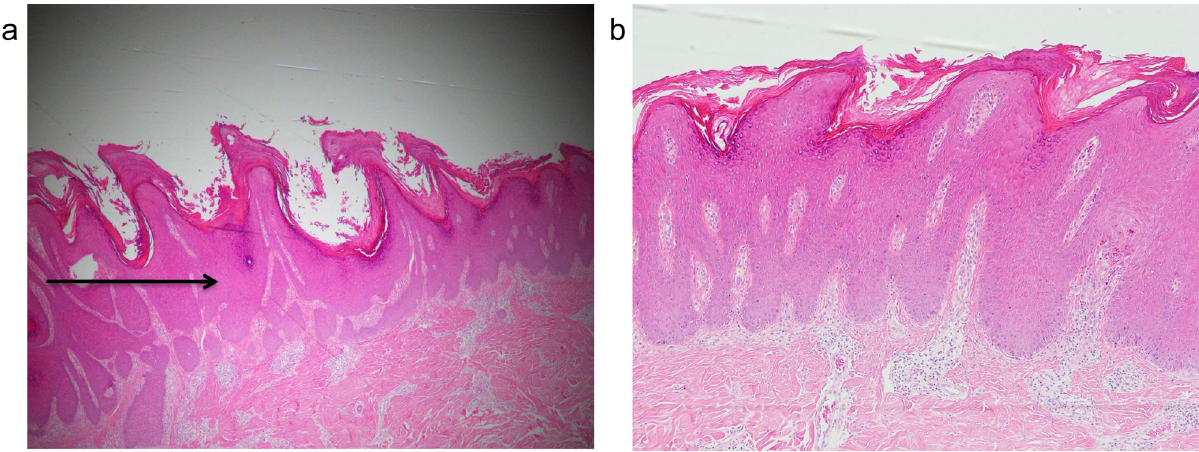
Figure 2: Histological observations of lesional skin biopsy from prurigo nodularis. Para ffi n - embedded sections of lesional skin from PN stained with hematoxylin and eosin. Lesional skin biopsy showed orthohyperkeratosis, hypergranulosis, and epidermal hyperplasia ( arrow ) ; the epidermis mostly consisted of keratinocytes. ( a ) Original magni fi cation × 40; ( b ) original magni fi cation × 100.